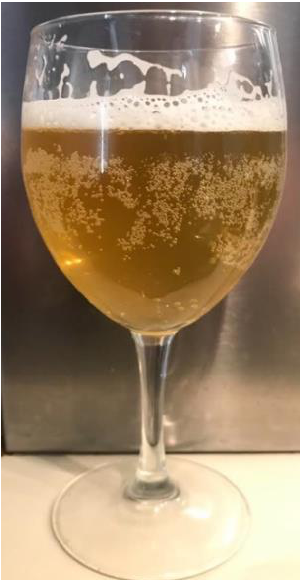
Figure 1. The control beer.